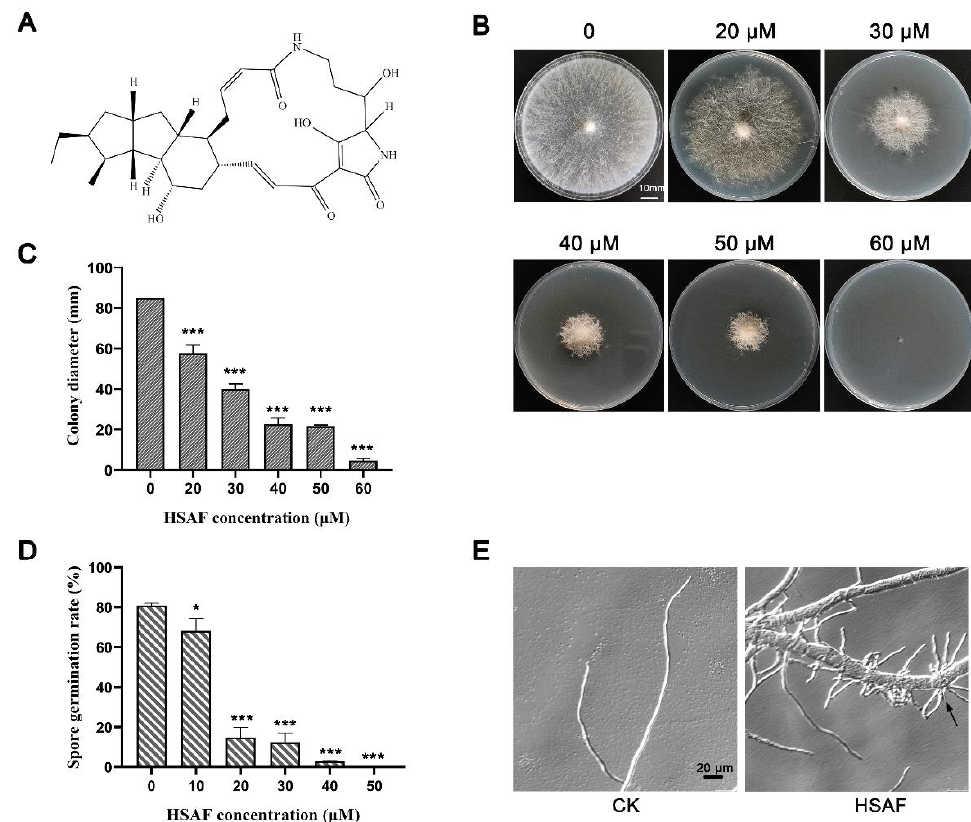
Figure 1. HSAF caused growth defect in N. crassa . ( A ) Chemical structure of HSAF; ( B ) Growth of N. crassa on Vogel’s plates supplemented with HSAF (0, 20, 30, 40, 50, 60 µM) for 36 h. Images show the results of one out of three experiments, and the statistical analysis of colony diameter is shown in ( C ); ( D ) Germination rate of N. crassa under HSAF treatment. Asterisks indicate significant differences (*, p < 0.05; ***, p < 0.001); ( E ) Microscopic morphology of N. crassa grown on Vogel’s media without (CK) or with 30 µM HSAF treatment (HSAF) for 6 h. The black arrow indicates the hyper-branch.